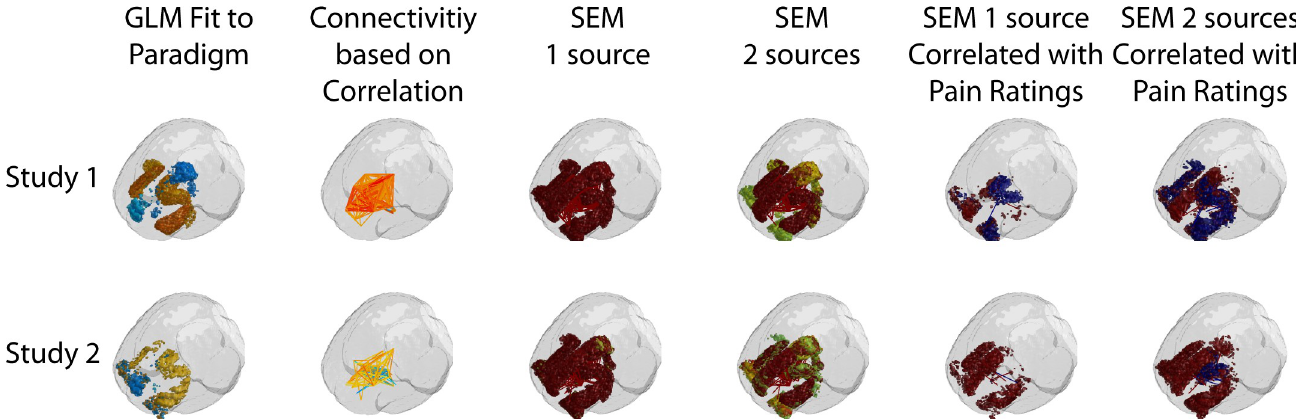
Fig 3. Anatomical regions identified with the analysis methods tested in brain regions. Regions are shown for the GLM fit, connections are shown for correlation results, and both regions and connections are shown for SEM results.